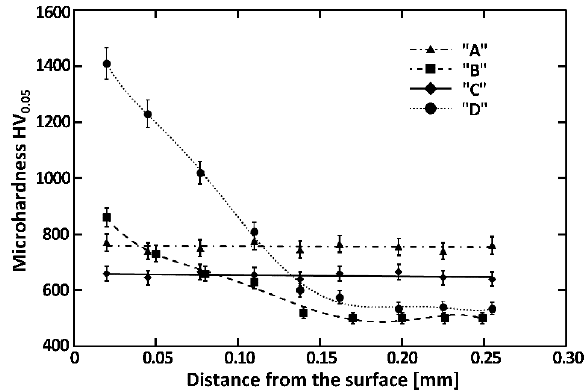
Figure 7. Microhardness vs. layer depth of the tested samples.